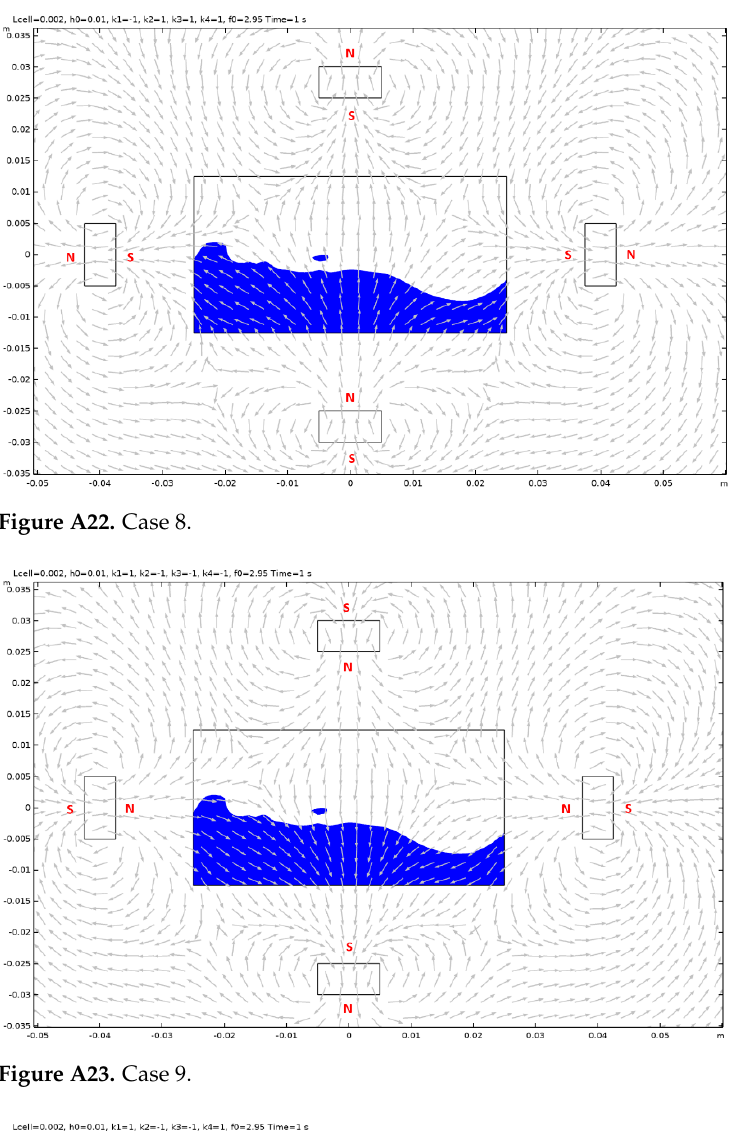
Figure A21. Case 7.